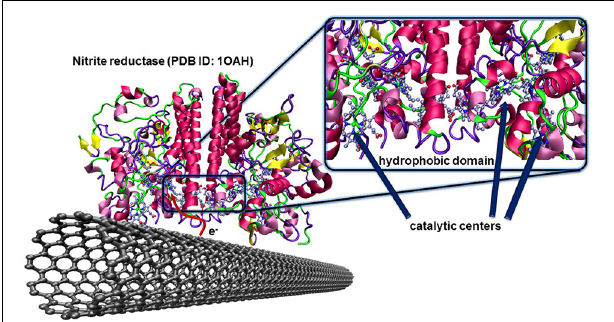
FIGURE 7 | Oriented immobilization of nitrite reductase from Desulfovibrio desulfuricans on CNTs via hydrophobic interactions between the enzyme and the carbon nanotube surface. This naturally occurring adsorption leads to an efficient electron transfer between the enzyme and the conducting surface where the redox center, after catalytic reduction of nitrite ions to ammonia, can directly be regenerated by the electrode.